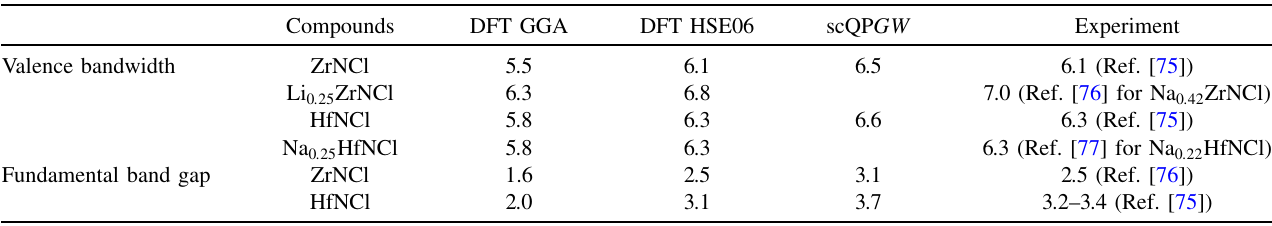
TABLE III. The valence bandwidths and the fundamental band gaps in ZrNCl and HfNCl and their electron-doped compounds, calculated using the DFT GGA, DFT HSE06, and scQP GW methods and compared with experiments [75–77]. The DFT HSE06 accurately reproduces both the valence bandwidths and the fundamental band gaps in both materials, whereas the DFT GGA underestimates the bandwidth by 0.5–0.7 eVand the band gap by about 1.0 eV. The scQP GW overestimates the valence bandwidth by 0.3–0.4 eV and the band gap by 0.5